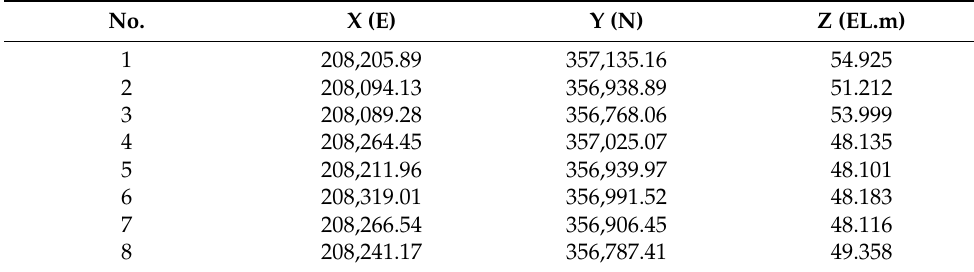
Table 2. Coordinates of the ground control points